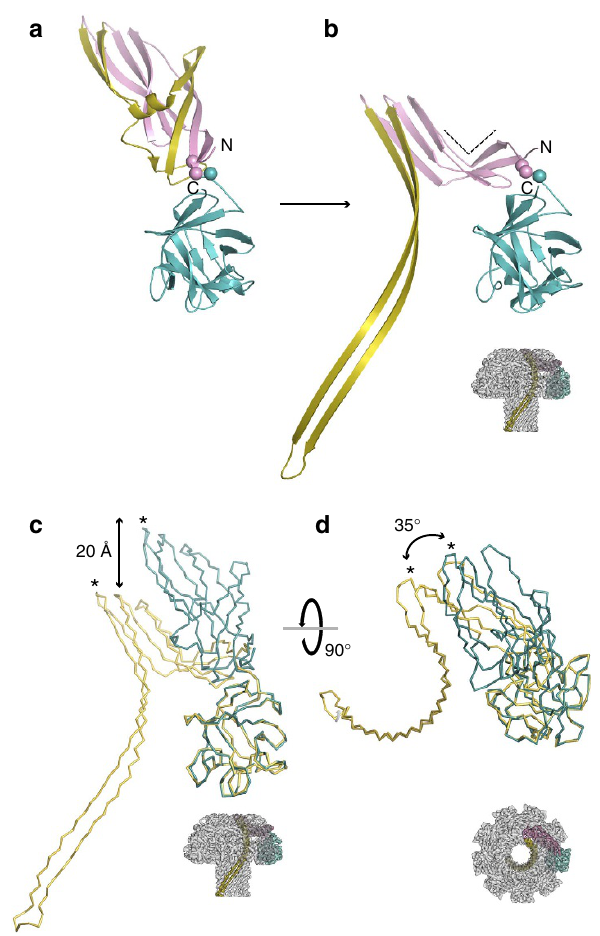
Figure 3 | Transition of water-soluble lysenin monomer to its membrane- inserted state. ( a ) Cartoon representation of the lysenin monomer (PDB ID 3ZXD) and its membrane-inserted state ( b ) with both molecules aligned in respect to the receptor-binding domain in the orientation indicated (inset). The dashed lines in b indicate the bend in the cap domain and the hinge residues (Val157–Arg159) are shown as spheres. The colouring scheme is as shown in Fig. 2a, with the N- and C-termini indicated. Ribbon representation of the superimposed water-soluble monomer (cyan) and its membrane-inserted form (olive) in reference to the receptor-binding domain, as seen from the side ( c ) and extracellular views ( d ). The asterisks point to Ser31 in both structures. The 20Å drop in height and the 35 (cid:2) rotation towards the lumen of the cap domain are